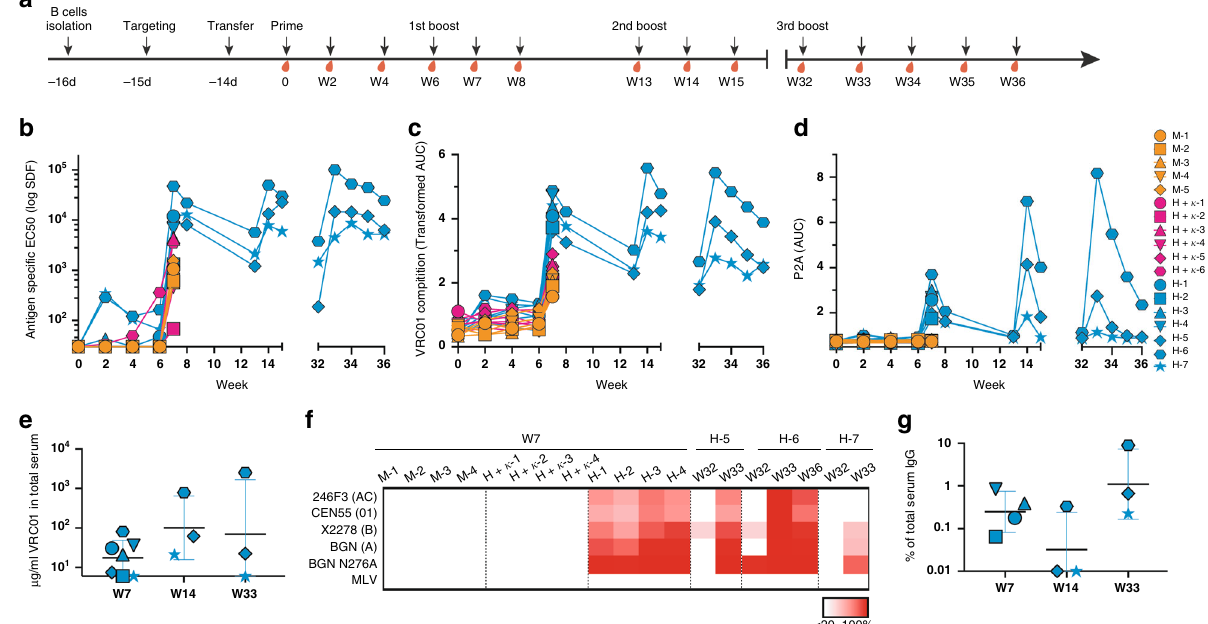
Fig. 2 Serological analysis of VRC01 responses after vaccination. a Engineered B cell vaccine experimental design. Time course of B cell engineering, cell transfer, immunization, and blood sampling in WT C57BL/6J mice. b – d Serum antibody responses after MD39-ferritin immunization in mice that received mock targeted, H-targeted , or H + κ targeted B cells. Titers ( y -axis) are given for the indicated timepoints ( x -axis) and mice (legend): b Total (host + donor) IgG response to the immunogen, given as serum dilution factor (SDF) EC50s; c VRC01-competetive antibody responses given as the transformed area under the curve (AUC) and; d Serum IgG carrying the P2A tag on engineered L-chains, given as area under the curve (AUC). e µ g/ml VRC01 in the serum. The quantity of VRC01 in the indicated serum samples at the indicated timepoints was calculated using a recombinant mouse VRC01-P2A-tagged IgG standard. n = 3-4 mice per group in n = 2 experiments. f Serum neutralization of HIV. IgG puri fi ed from the serum of the indicated mice at the indicated timepoints was tested for its ability to neutralize HIV pseudoviruses using the TZM-bl assay. Percent neutralization of virus achieved by 200 µ g/ml of IgG is given as a heat map for several tier-2 viruses from different clades (BGN = BG505) when neutralization decreases with IgG concentration. g VRC01 antibody as a fraction of the total serum IgG. The fraction of total serum IgG with functional VRC01 activity was assessed for the indicated mice at the indicated timepoints (weeks post-prime) by comparing the BG505-N276A neutralization IC50 values for these samples with the recombinant